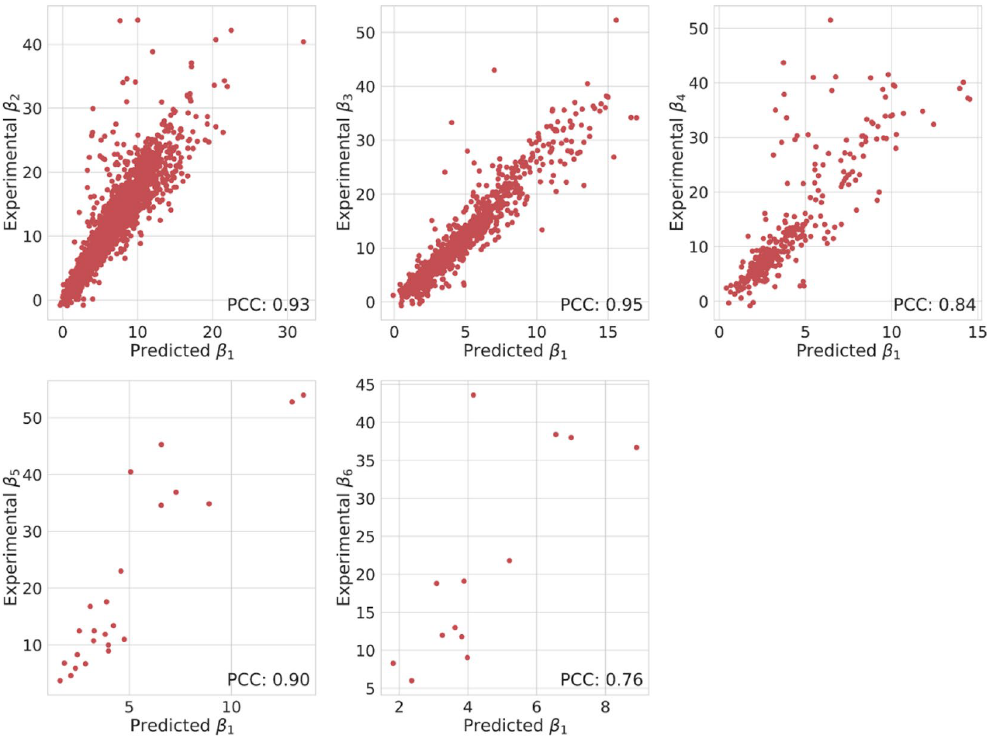
Figure 3. Relationships between experimental multi-order β n and predicted β 1 of the corresponding M-L pair. The results of Pearson correlation coefficients (PCC) are also displayed.